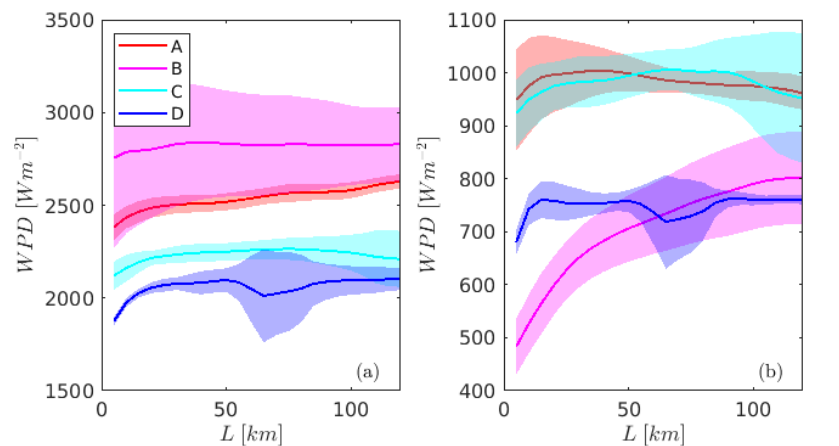
Figure 8. The WPD as function of the distance from the coast for January ( a ) and July ( b ) in the four chosen areas from Exp1. A, B, C, and D represent the Danish west coast, British east coast, coastal areas of Lithuania and the Polish coast, respectively (shown in Figure 2). The shaded areas represent the standard deviation.